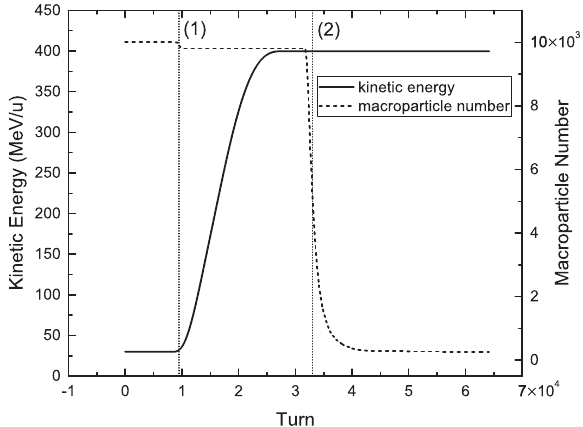
FIG. 6. Beam loss and kinetic energy change over time in the Kr 19 þ simulation. Beam loss (1) is related to the longitudinal dynamics and the beam loss (2) is related to the transverse coupled-bunch instability.